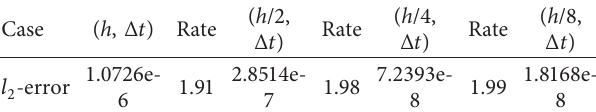
Table 4: Convergence test results of the CN method for space step.